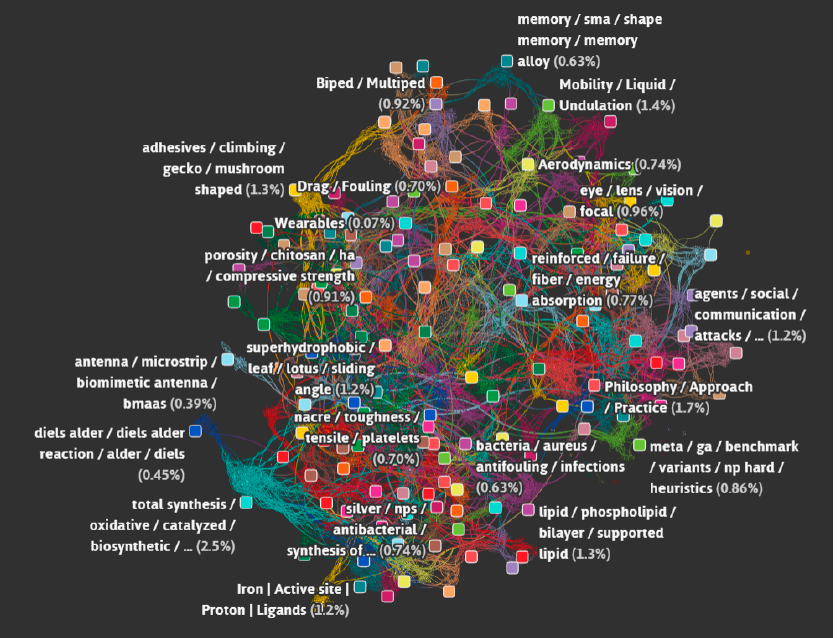
Figure 11. The biomimetic landscape based on academic publications accessible through SCOPUS.